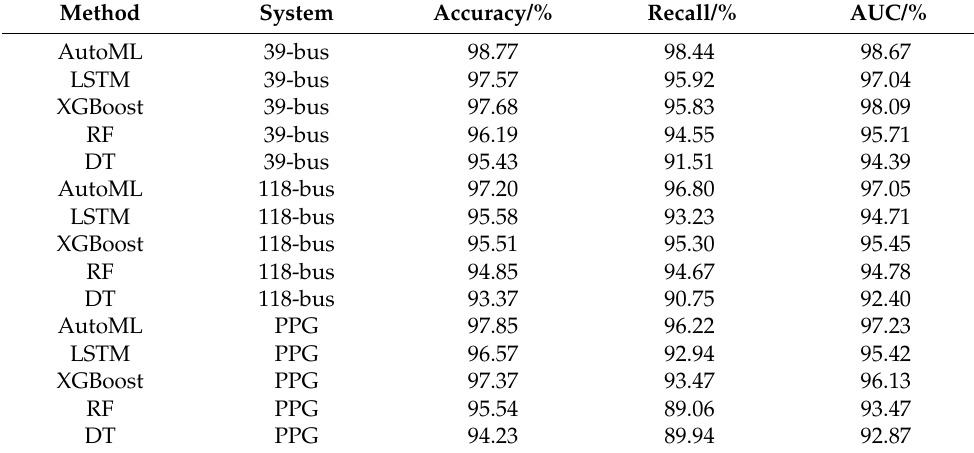
Table 3. Results obtained by different methods on the three power